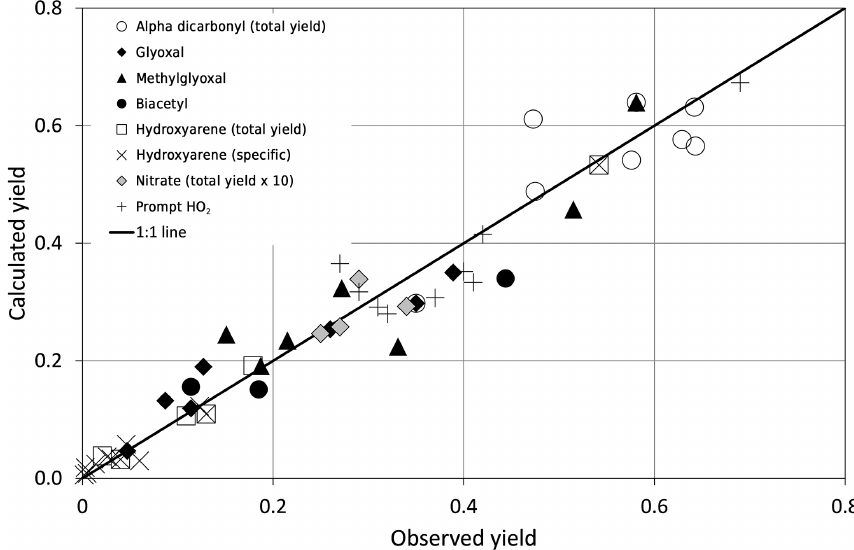
Figure 5. Correlation of calculated and observed yields of hydroxyarenes (total and specific), α -dicarbonyls (total and specific), peroxide- bicyclic nitrates (total) and prompt HO 2 formed from the degradation of benzene and methyl-substituted aromatic hydrocarbons. Observed data taken from Atkinson and Aschmann (1994), Smith et al. (1998, 1999), Klotz et al. (1998), Volkamer et al. (2001, 2002), Berndt and Böge (2006), Noda et al. (2009), Rickard et al. (2010), Elrod (2011) and Nehr et al. (2011, 2012), as summarized in Tables S1 and S2.